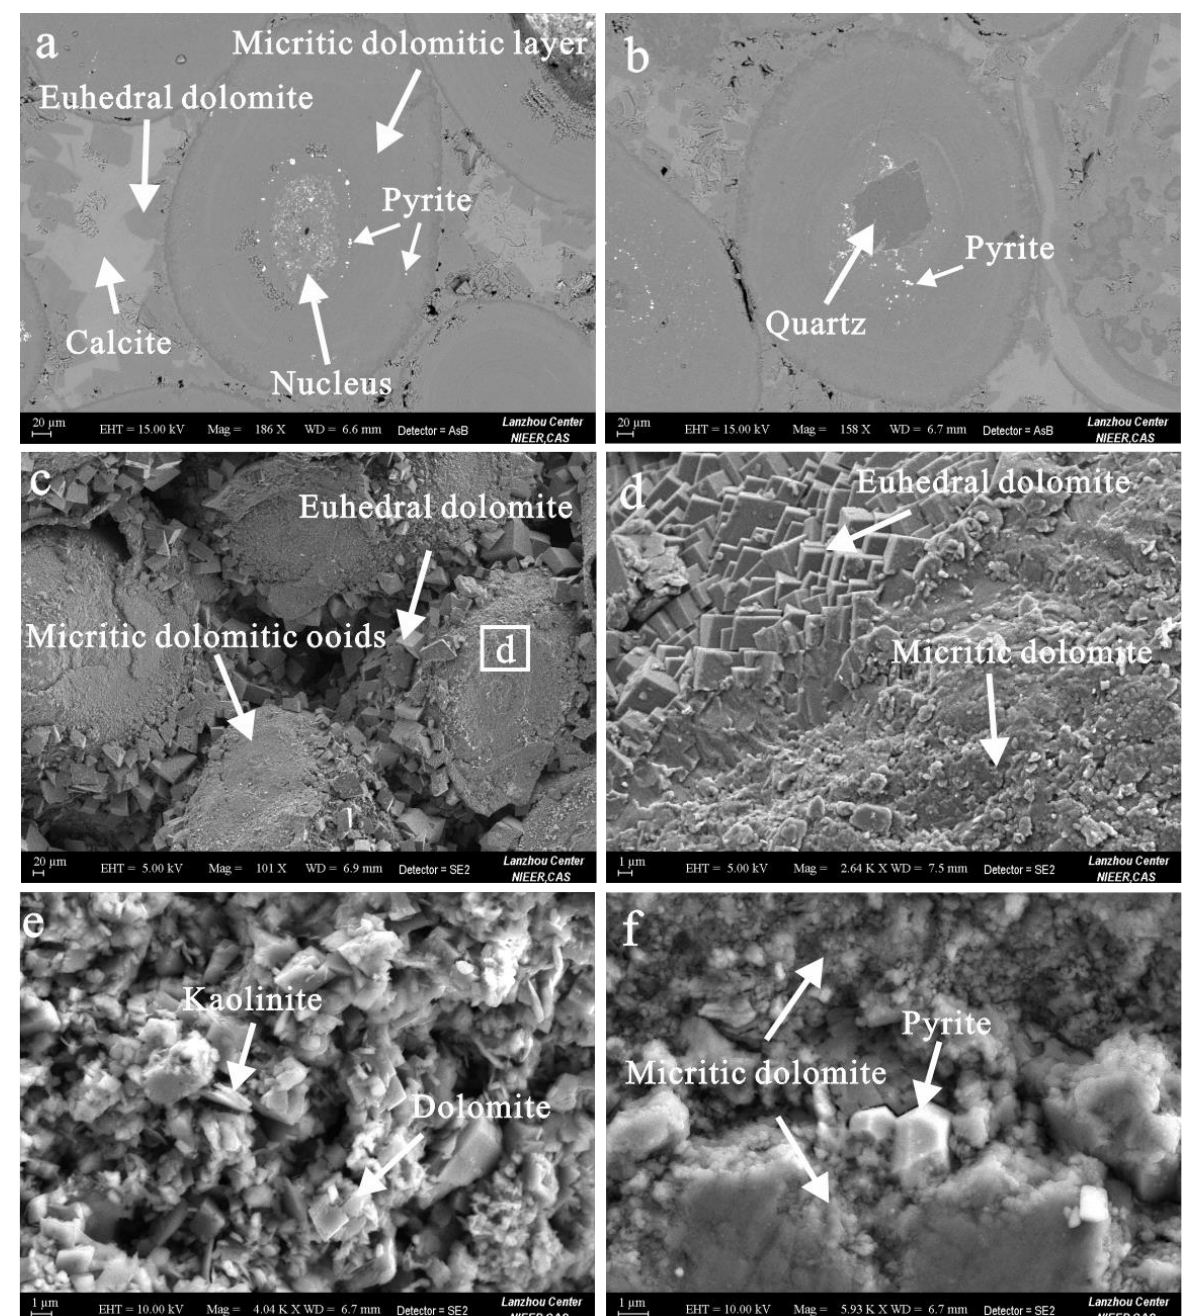
Figure 5. Scanning electron micrographs of the sample. ( a , b ) ASB images show concentric micritic dolomitic layer, micritic dolomitic and quartz nucleus, and pyrite in nucleus and cortices; ( c ) SE image shows that planar-e (euhedral) dolomite crystals were developed on the surface of ooids and in the pores; ( d ) SE image shows inner micritic dolomite with a plate pattern and outer euhedral dolomite crystal with a rhombic shape; ( e ) SE image shows minor kaolinite in the nucleus; ( f ) SE image shows that pyrites developed in the micritic dolomitic cortices.